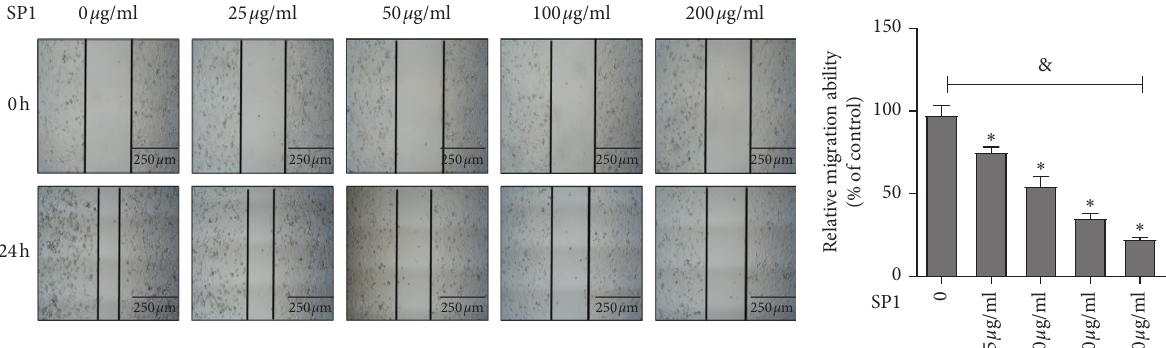
Figure 4: Scratch assay was used to detect the change of cell migration ability in MGC-803 cells treated with different concentrations of SP1 (0, 25, 50, 100, and 200 μ g/ml) for 24h Compared with 0 μ g/ml SP1-treated (control) group, ∗ P < 0 . 05; & P < 0 . 05 for comparison between groups under different concentrations of SP1